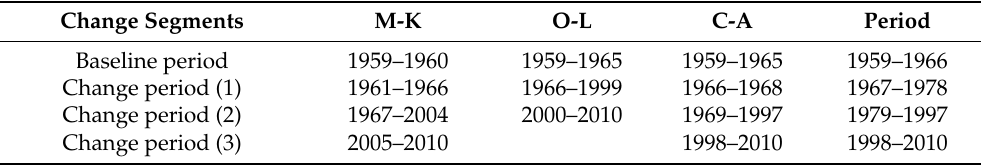
Table 2. Summary of change segment results for hydro-meteorological variables. M-K =